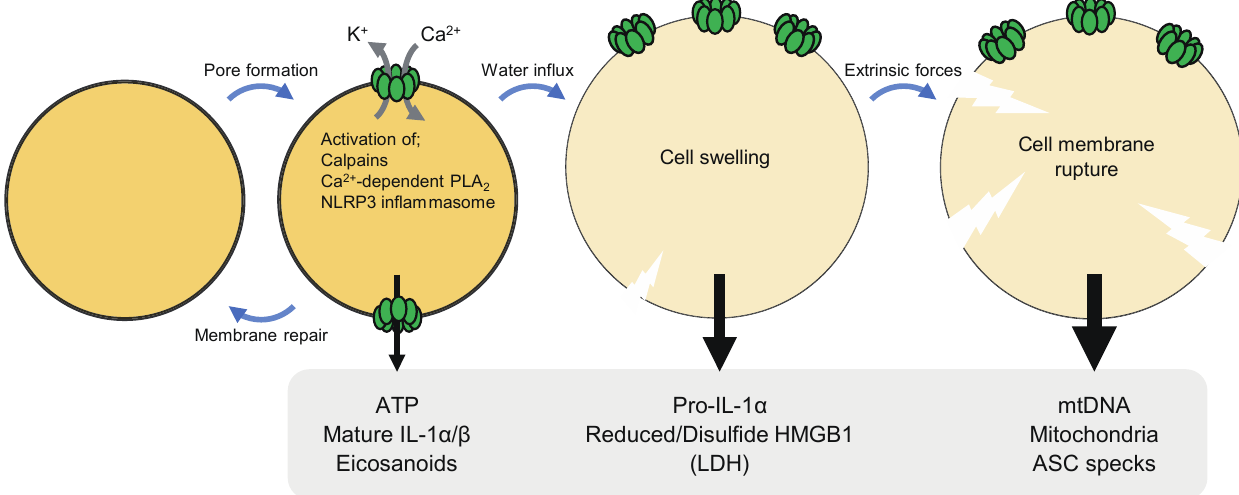
Figure 3. Damage-associated molecular patterns (DAMPs) and cytokines released from cells undergoing pyroptosis. The formation of GSDM pores in the plasma membrane causes the dissipation of ion gradients and release of small cytosolic molecules that can pass through the pores. Thereafter, GSDM pores cause cell lysis due to water influx, allowing the release of large cytosolic contents. ATP and mature IL-1α/β can be released through GSDM pores. The release of HMGB1 appears to require cell lysis. Immunostimulatory forms of (reduced and disulfide) HMGB1 may be released from pyroptotic cells. Severe cell membrane rupture can lead to the release of mitochondrial DNA (mtDNA), mitochondria, nuclei, and caspase recruitment domain (ASC) specks. Ca 2+ influx via GSDM pores results in the activation of calpains, which process pro-IL-1α into the mature form. Ca 2+ -dependent phospholipase A 2 (PLA 2 ) also produces free arachidonic acid, which is the precursor for other eicosanoids. On the other hand, K + efflux via GSDMD pores activates the NLRP3 inflammasome.